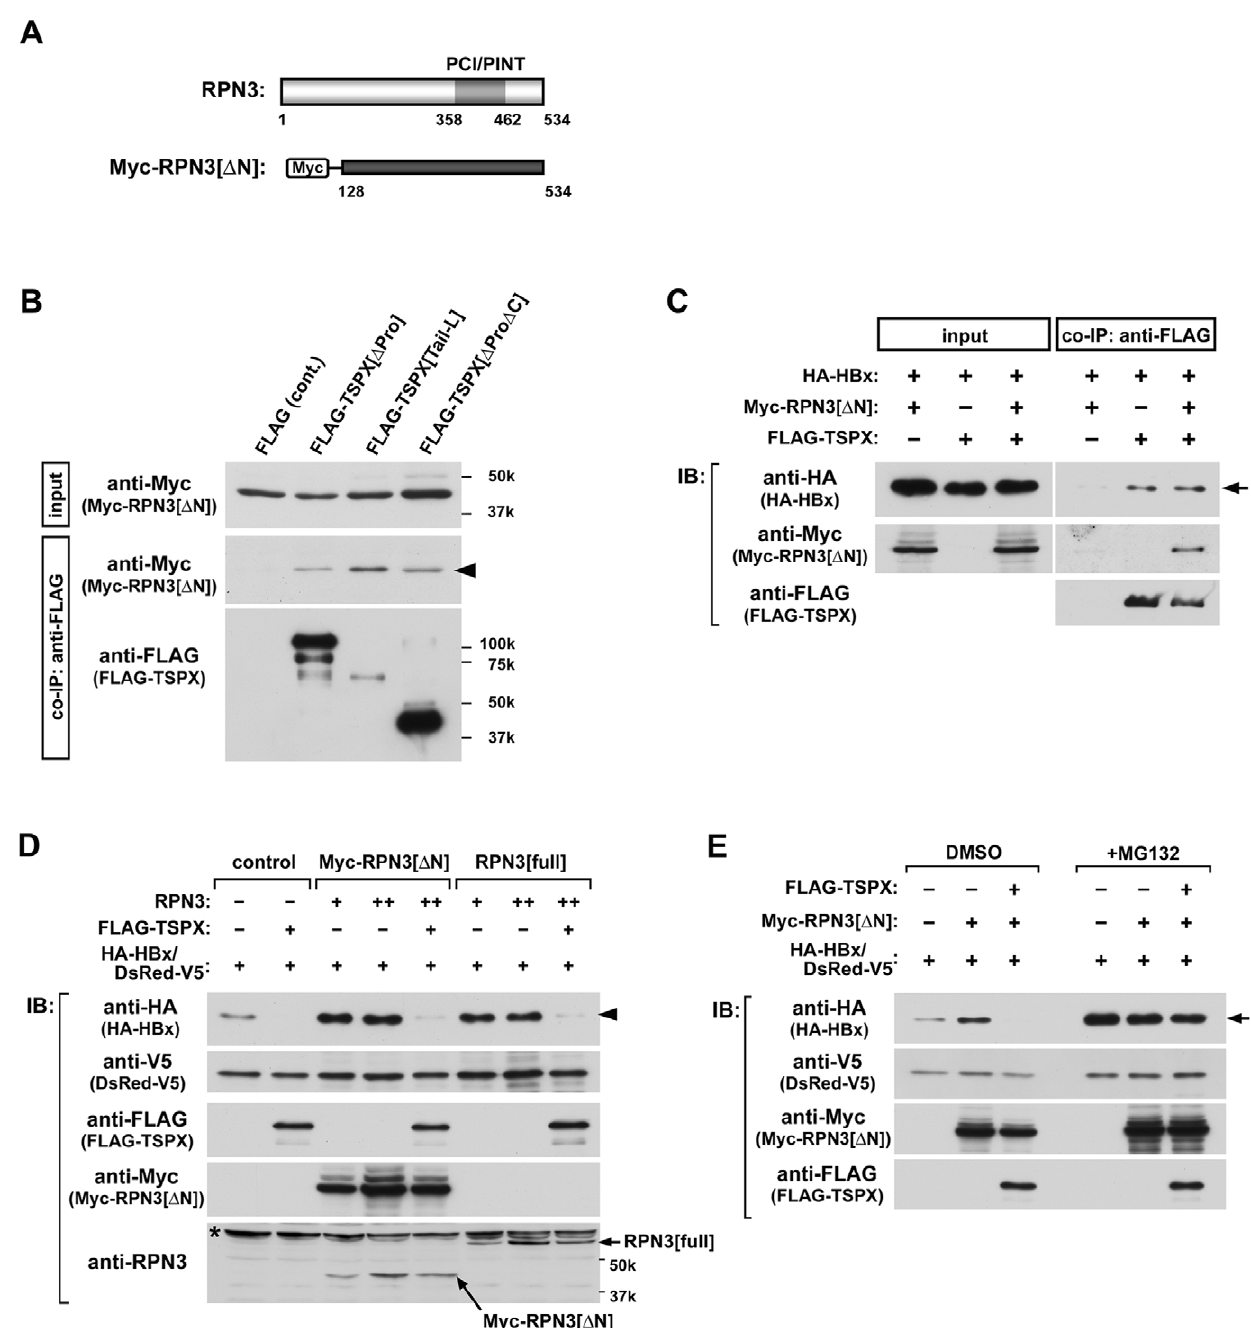
Figure 4. TSPX interacts with RPN3, and abrogates the protective effect of RPN3 on HBx-degradation. (A) Structure of RPN3 and schematic representation of the truncated mutant of RPN3. The position of PCI/PINT domain is as marked. N-terminal truncated RPN3 (residues 128– 534 a.a., termed as RPN3[ D N]) was cloned into pCMV-Myc vector to express a Myc epitope-tagged product. (B) Interaction of TSPX and RPN3 in mammalian cells. Myc-RPN3[ D N] was co-transfected with p3 6 FLAG-CMV7 (FLAG control), FLAG-TSPX[ D Pro], FLAG-TSPX[Tail-L] or FLAG-TSPX[ D Pro D C] into 293T cells. Immunoprecipitations were carried out as before using anti-FLAG antibody. Immunoblots were probed with anti-Myc and anti-FLAG antibodies. The immunoblots indicate that human RPN3 co-immunoprecipitates with human TSPX. (C) RPN3 did not interfere the interaction between TSPX and HBx. HA-HBx and FLAG-TSPX[ D Pro] expression vectors were co-transfected with or without Myc-RPN3[ D N] vector into 293T cells. Immunoprecipitations were carried out using anti-FLAG antibody. Immunoblots were probed with anti-HA, anti-Myc and anti-FLAG antibodies, respectively. The results indicate that interaction between HA-HBx and FLAG-TSPX was not affected by co-expression of Myc-RPN3[ D N]. (D) Over- expression of RPN3 protected HBx from protein-degradation, and TSPX overcomes the protective effect of RPN3. 293T cells were co-transfected with HA-HBx (0.2 m g/well), Myc-RPN[ D N] (0.05, 0.1 m g/well), RPN3[full] (0.05, 0.1 m g/well) and/or FLAG-TSPX[ D Pro] (0.05 m g/well) as indicated in the figure. pcDNA-DsRed-V5 expression vector (0.1 m g/well) was co-transfected as the internal control for monitoring the transfection efficiency. Cells were lysed 48 h after transfection, and analyzed by Western blot using indicated antibodies. Although co-transfection of RPN3[full] or RPN3[ D N] resulted in the increase of HA-HBx, TSPX significantly decreased the level of HBx even in the presence of RPN3. (E) Over-expression of Myc-RPN3[ D N] did not affect